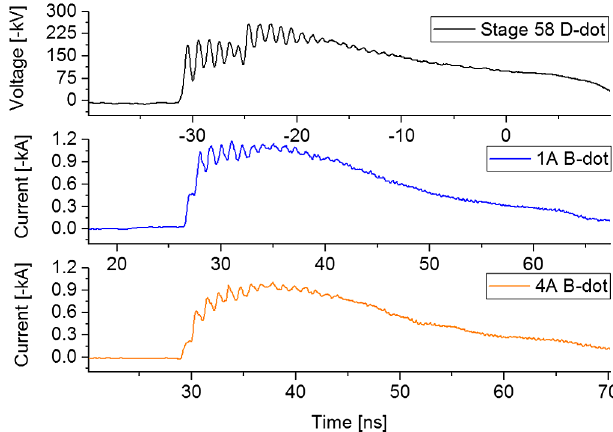
FIG. 6. Voltage trace measured at the NLTL Stage 58 D-dot and beam current traces measured at the 1A and 4A B-dot locations for Shot 20 of the 25 kV series.